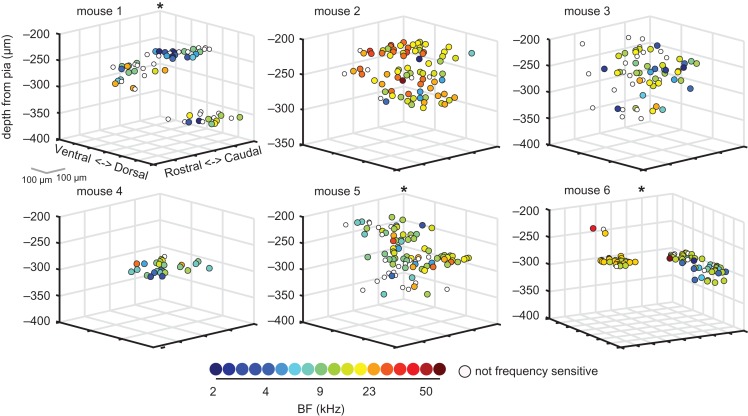
Neuronal sensitivity to pure tone frequency is more homogeneously distributed than sensitivity to ILDs. Three-dimensional plots of the relative cortical location of neurons in the same mice shown in Figures 6B and 7B. Neurons are color-coded according to their BF. Tone-responsive neurons that did not show significant frequency sensitivity are shown in white.